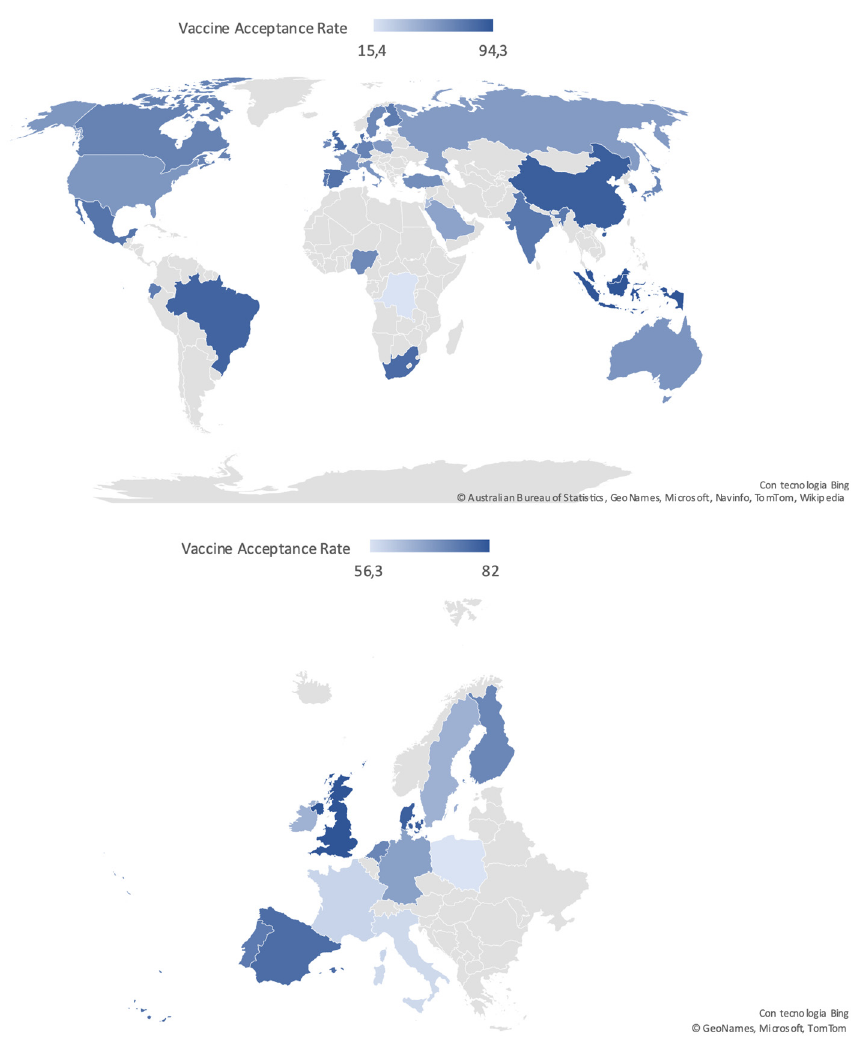
Figure 2. Worldwide and European distribution of COVID-19 vaccine acceptance rates in the general population, defined according to the most recent available data.